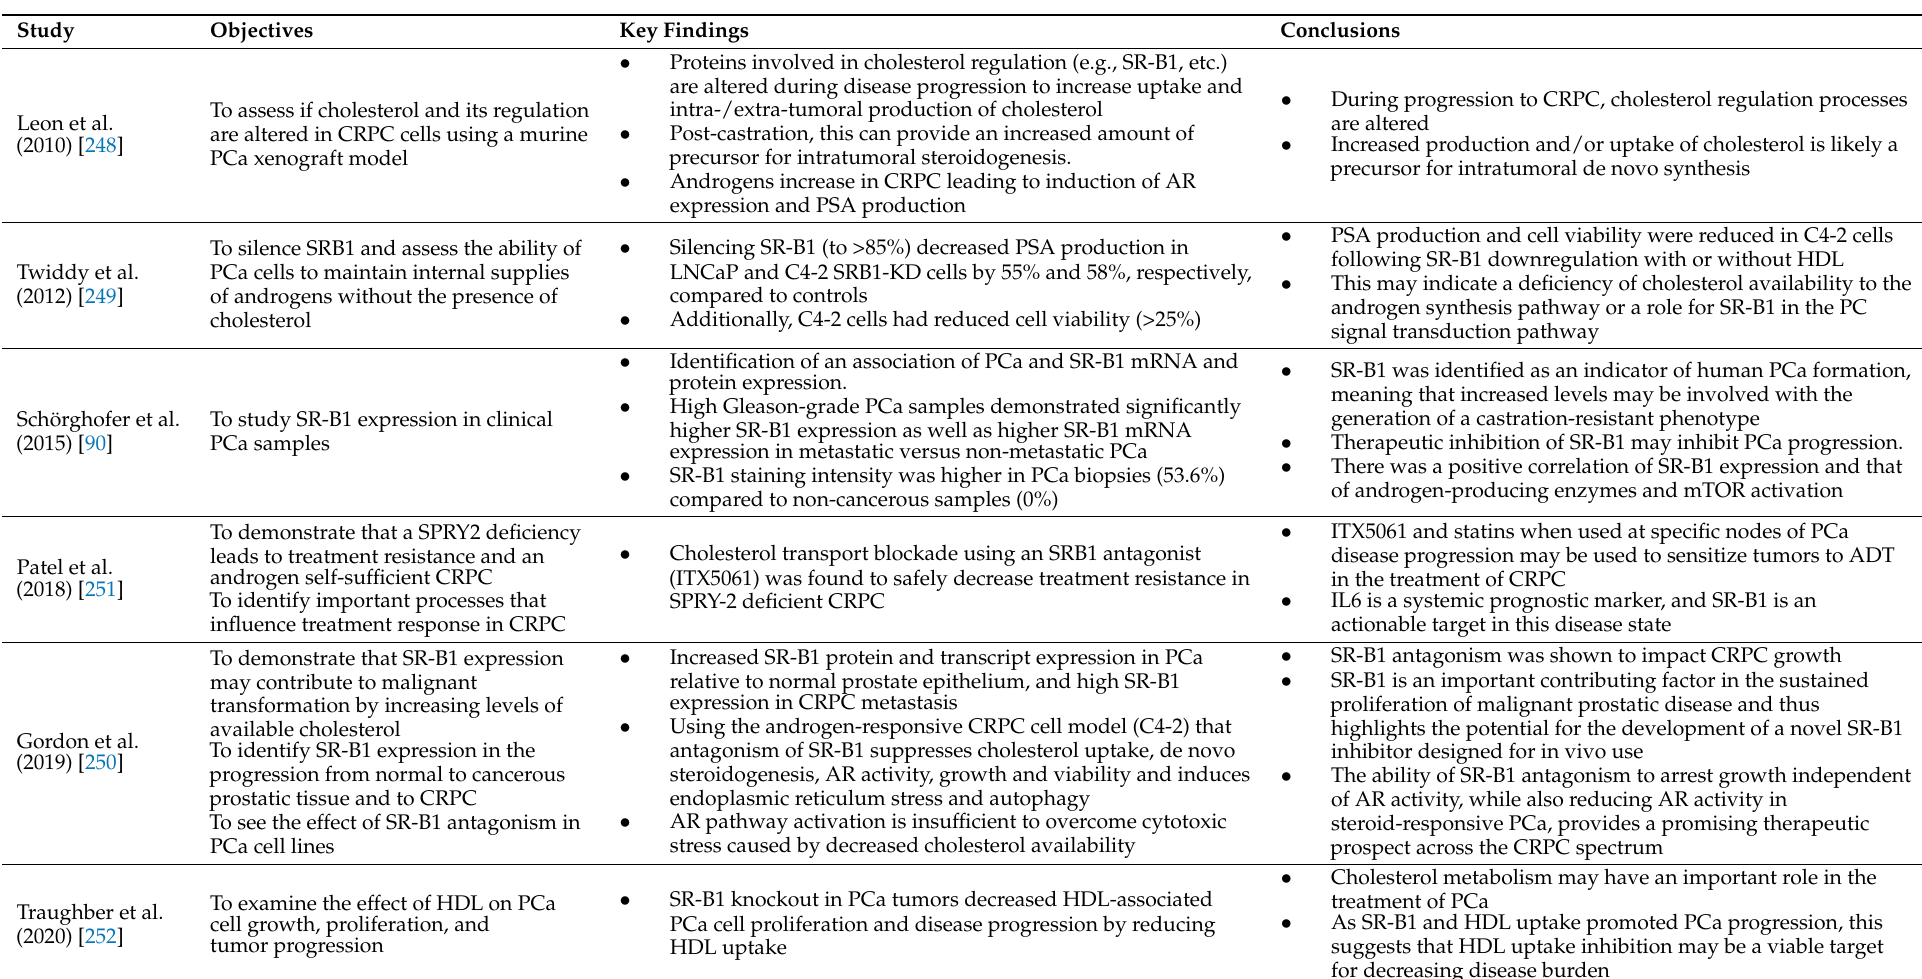
Table 3. SR-B1 as a potential therapeutic target for management of